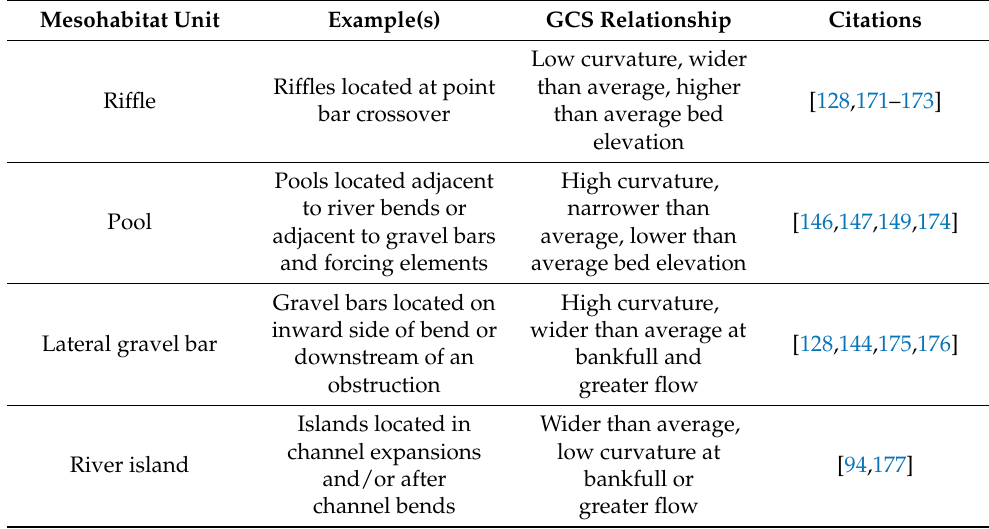
Table 2. Archetypal geomorphic covariance structure (GCS) relationships for riffle, pool, gravel bar and river island mesohabitat